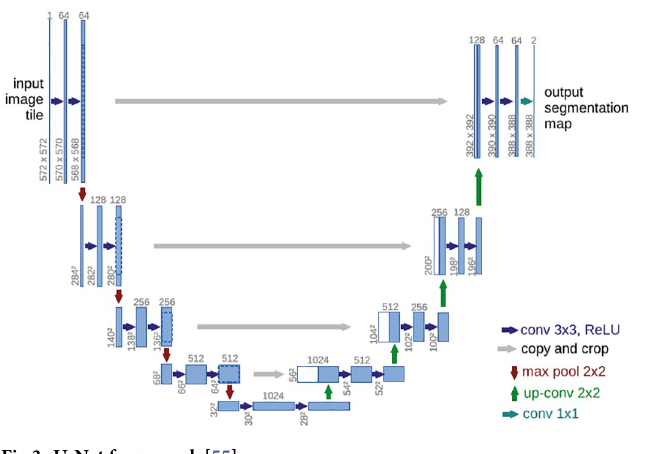
Fig 3. U-Net framework